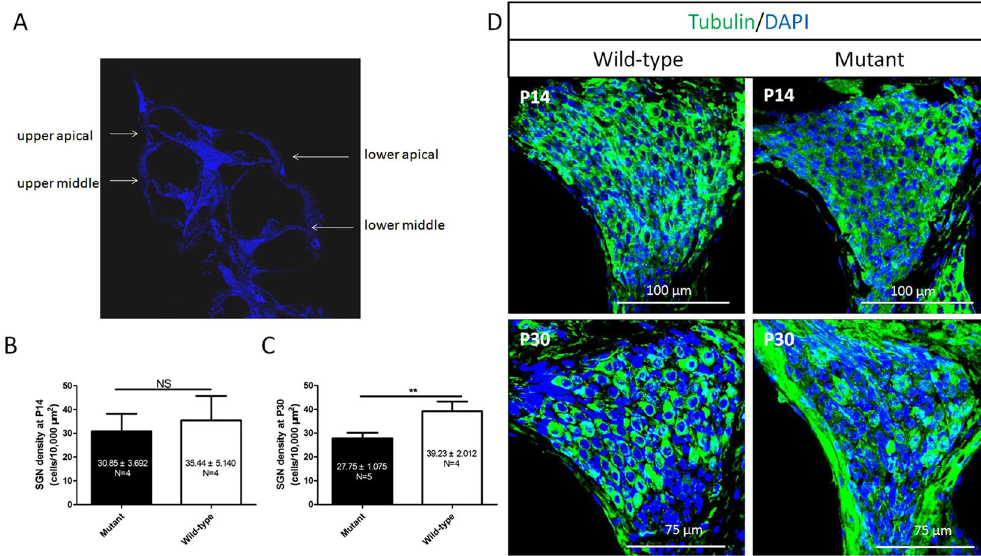
Figure 2. SGN density SGNs density at postnatal days 14 and 30 days (P14 and P30). ( A ) In order to reduce the error, only the upper middle turn in the frozen section through the modiolus was analyzed as illustrated. ( B ) At P14, there are no significant differences in SGN density between the mutant and wild-type mice (P > 0.05). ( C ) However, density was significantly different in SGN at P30 between the wild-type (39.23 ± 4.024, N = 4) and Spag6 mutant mice (27.75 ± 2.403, N = 5)(P < 0.01). ( D ) Immunofluorescence staining of SGN with a neuron-specific marker ( β -tubulin Ш) at P14 and P30. “N” indicates the number of mice. * P < 0.05, ** P < 0.01, *** P < 0.001. Comparisons between groups were tested by Student’s